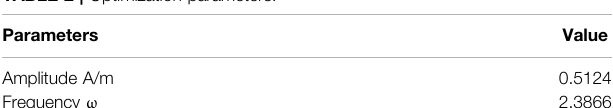
TABLE 1 | Natural Frequencies of the highway bridge. TABLE 2 | Optimization parameters.